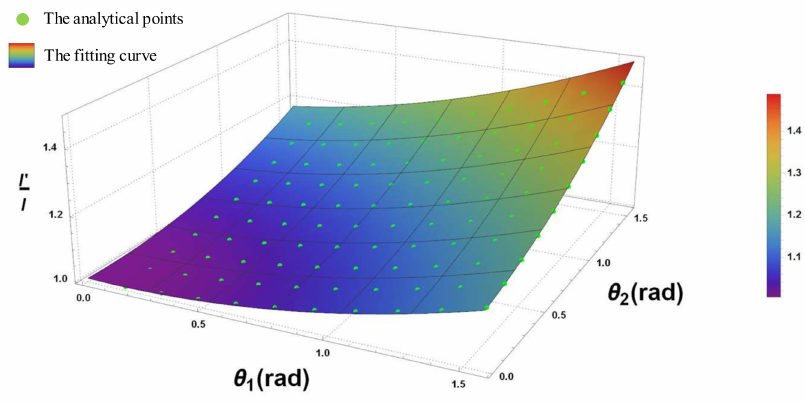
Figure 8. Nonlinear regression of length coefficient.